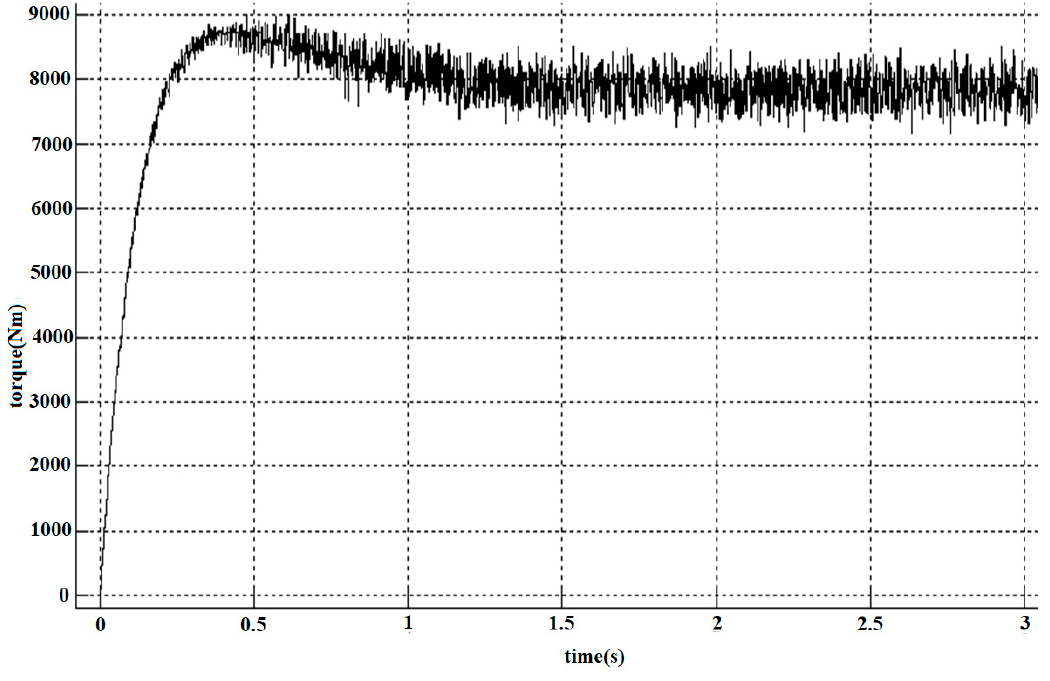
Figure 25. Torque waveform of the motor.